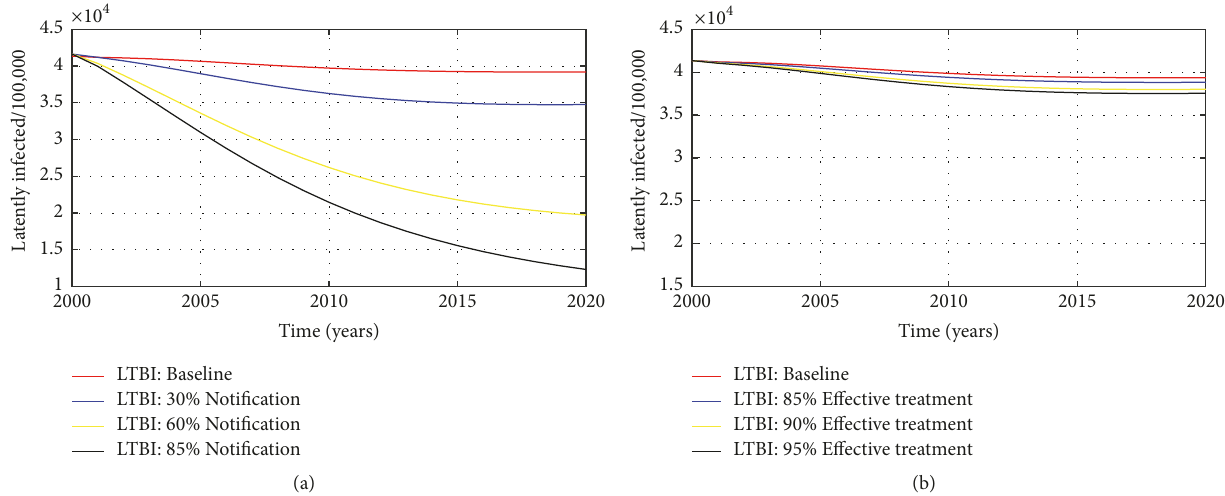
Figure 7: Hypothesis 3: changes in latent tuberculosis with respect to an increase in notification rate or in effective treatment. (a) Simulated dynamics of the latentlyinfected population (LTBI) with differentnotificationlevels,with all otherparameterskept constant in thepopulation of Nigeria. The red curve shows the LTBI population that remained constant for more than 20 years, thereby producing new sick people constantly. With an increase in notification up to 30%, the pool of the LTBI starts decreasing (blue curve), and a further increase in notification shows a much higher decrease in the pool of LTBI (black curve, 85% notification rate). (b) Simulation of the LTBI population with improvement in effective treatment, with all other parameters kept constant in the population of Nigeria. There is little or no change in the number of LTBI cases before and after increasing the effective treatment.